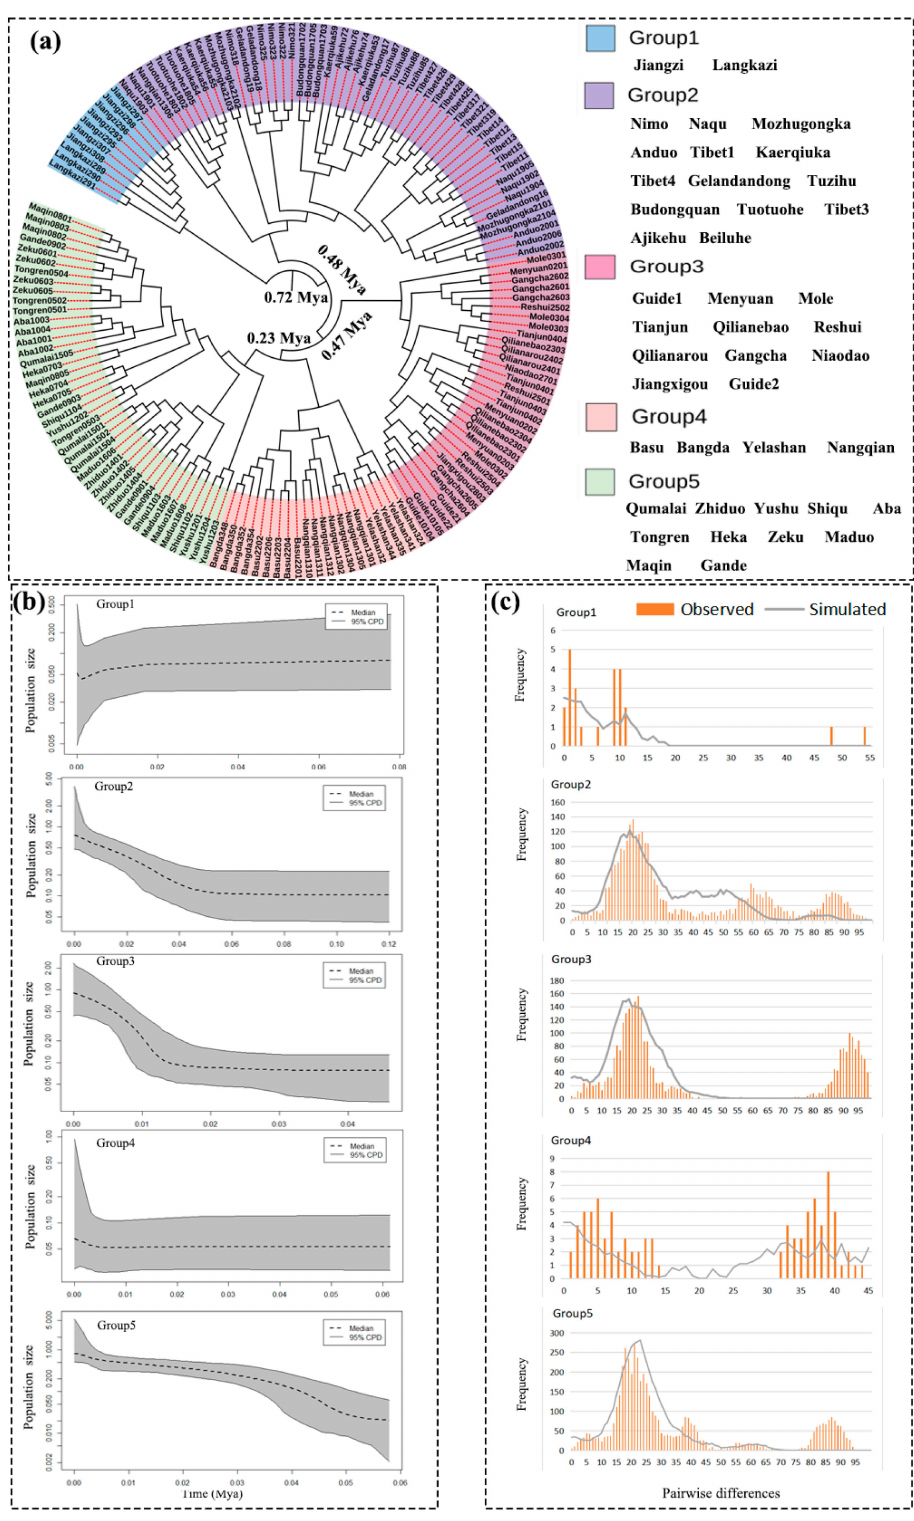
Figure 4. Historical dynamic analysis of plateau pika population. ( a ) Phylogenetic time-tree of plateau pika populations. ( b ) Bayesian skyline plots (BSPs) for population dynamics with the time of plateau pikas in the middle and lower reaches; dotted lines indicate median values and solid lines indicate 95% upper and lower confidence intervals. ( c ) Mismatch distribution analysis diagram of each group of plateau pika